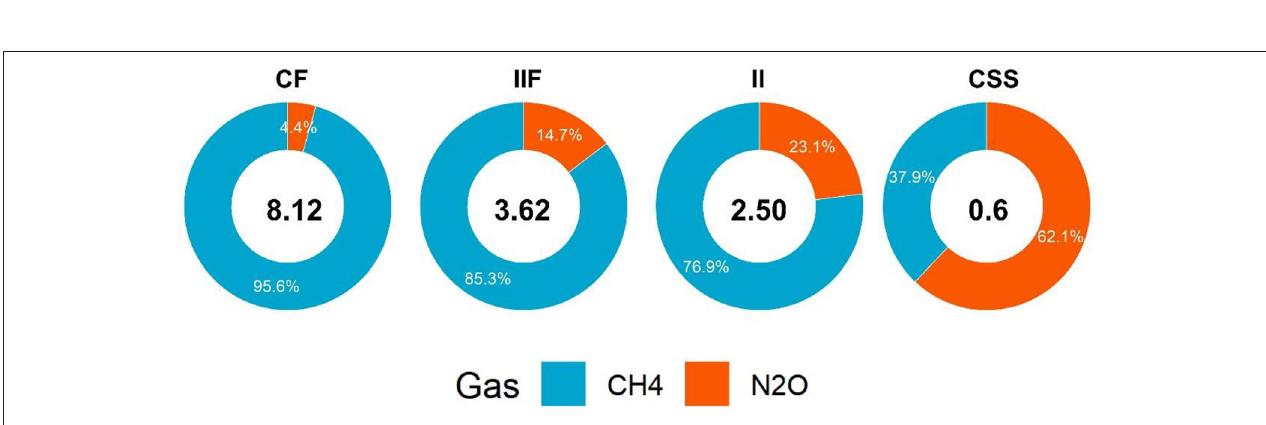
FIGURE 3 | Simulations of (A) Total Water Input (TWI); (B) rice yield; (C) methane (CH 4 ); (D) nitrous Oxide (N 2 O); (E) Water productivity (WP); (F) Greenhouse Gas Intensity (GHGI) under Continuous Flooding (CF), Intermittent Irrigation (II); Intermittent Irrigation until Flowering (IIF) and Continuous Soil Saturation (CSS) for the period 2014-2019.